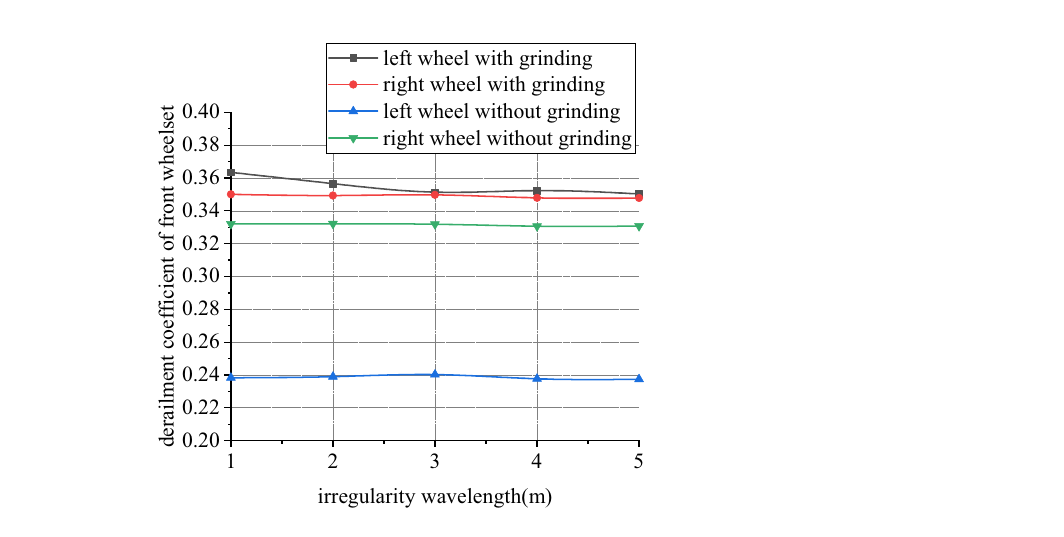
Figure 24. Wavelength and derailment coefficient (case 2).